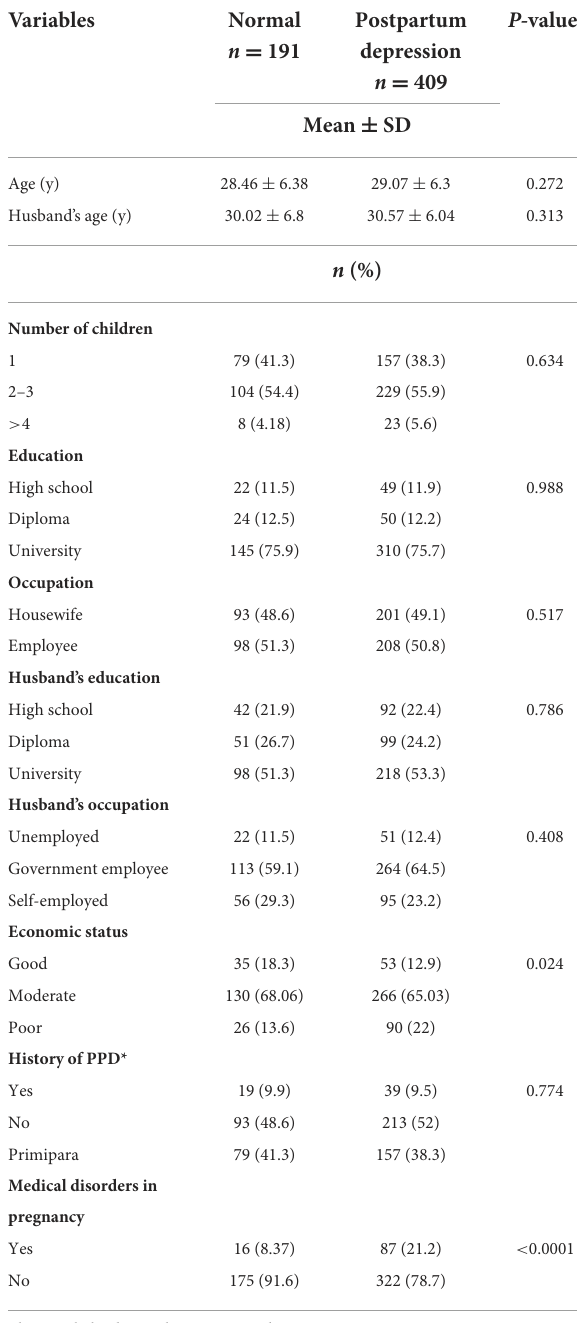
TABLE 1 Demographic characteristics of participants according to the severity of depression during COVID-19 pandemic.